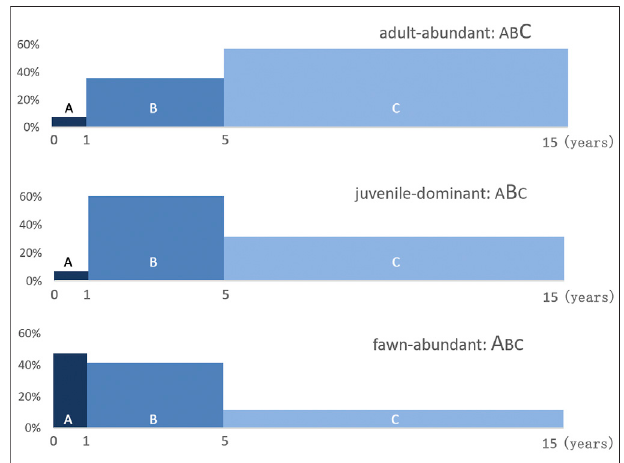
FIGURE 4 | Age compositions of the three sika deer hunting